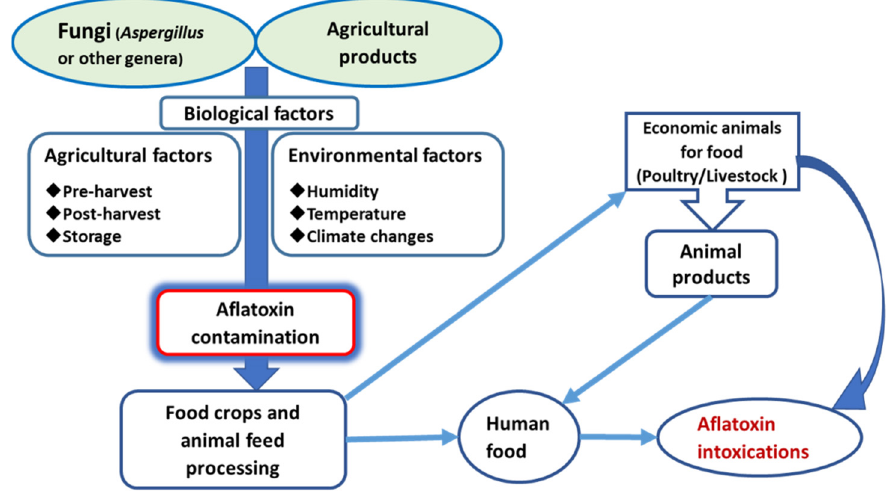
Figure 1. Aflatoxin intoxication via feed and food supply